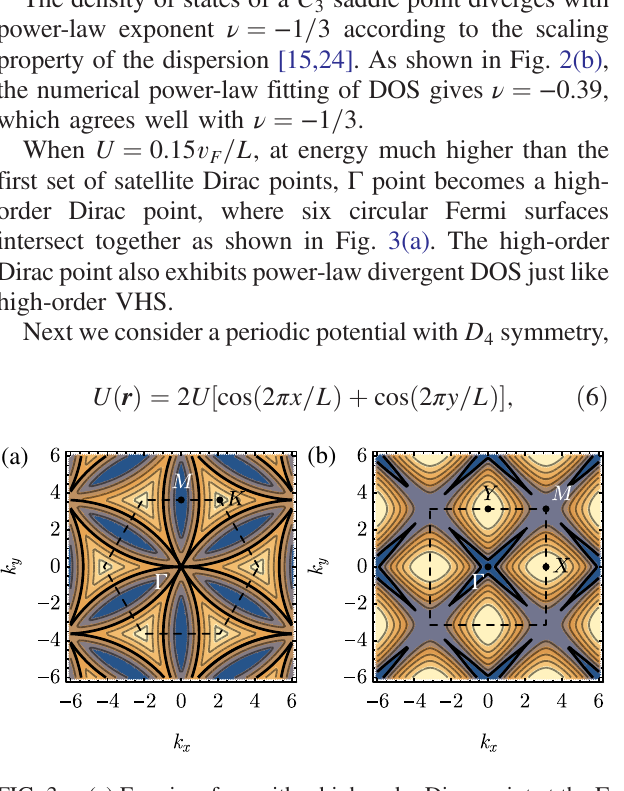
FIG. 3. (a) Fermi surface with a high-order Dirac point at the Γ point in C 6 potential Eq. (4). (b) Fermi surface with a high-order VHS of class A 2 on the high-symmetry line Γ M in D 4 potential Eq. (6). The Fermi surfaces passing through high-order VHS are plotted in thick black curves, among which those in (a) are perfect circles. The corresponding MBZ is plotted in dashed